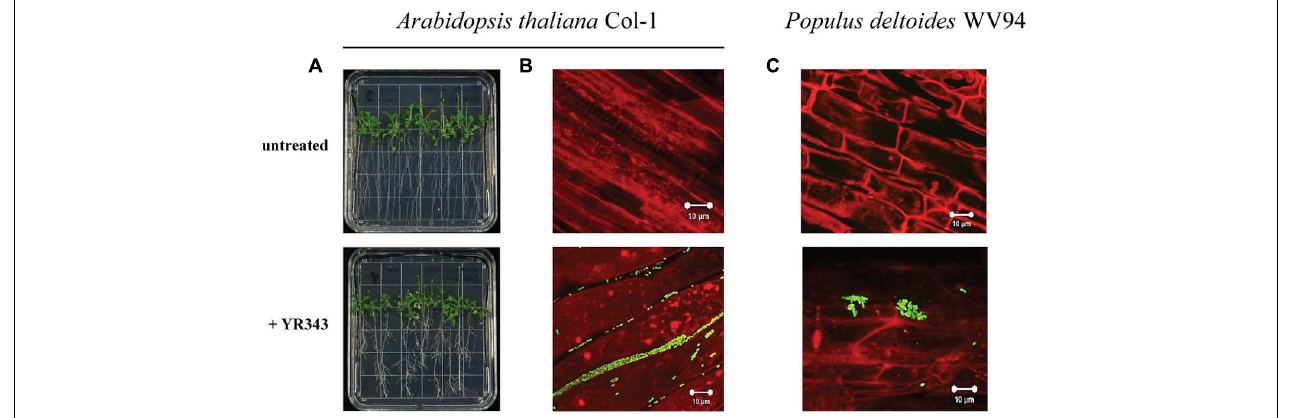
FIGURE 3 | Colonization of plant roots by Pantoea sp. YR343. (A) Arabidopsis thaliana plants were grown on MS plates in the absence or presence of Pantoea sp. YR343 for 10 days prior to imaging. (B) Corresponding to the pictures in (A) are images of roots taken with confocal microscopy. The image on top shows roots from an uninoculated plant, while the bottom image shows roots colonized by YR343-pGFP. (C) Populus deltoides WV94 cuttings were grown in the presence or absence of Panteoa sp. YR343 expressing GFP. (Top) untreated P. deltoides WV94 plant; (bottom) P. deltoides WV94 cultured with YR343-pGFP for 7 days. In all images, Pantoea sp. YR343 is detected by GFP fluorescence (green) and plant roots are detected using autofluorescence (red).